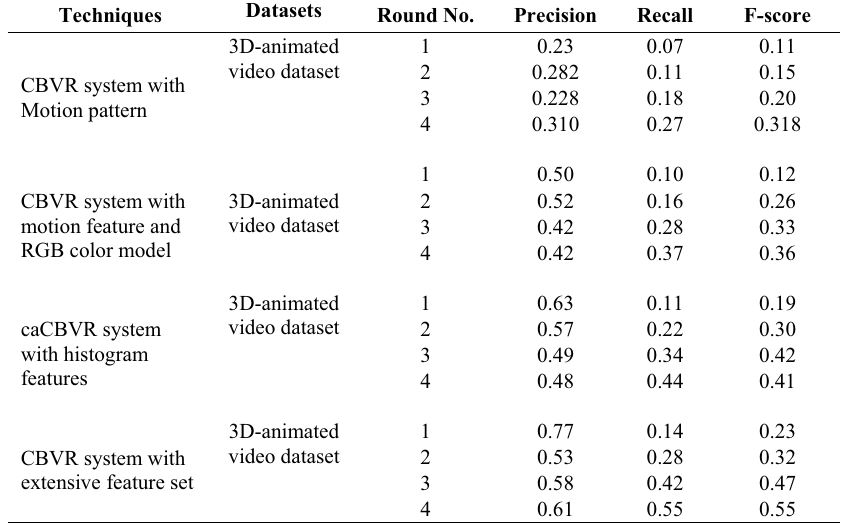
Table. 5.Comparison plot of Mean (i) Precision, (ii) recall and (iii) F-score values for different rounds of retrieval obtained by the proposed CBVR system and other existing systems with 3D- animated video dataset.